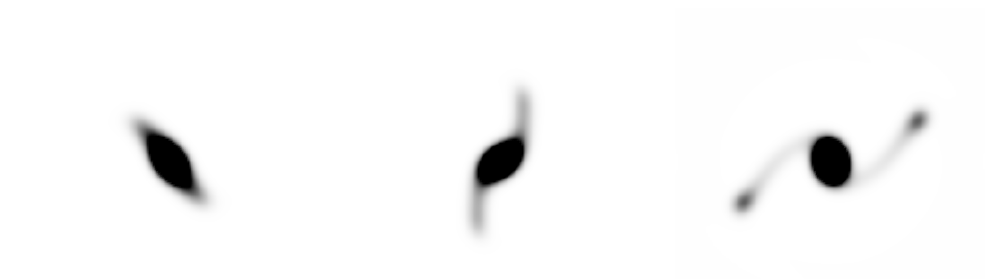
Figure 13 . Snapshots of time evolution of the fundamental n y = 4 mode added with negative amplitude (i.e., creating a bulge in the middle, instead of a